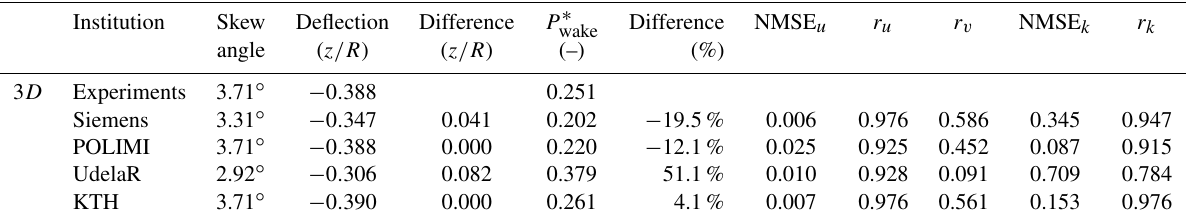
), and their differences to the wake